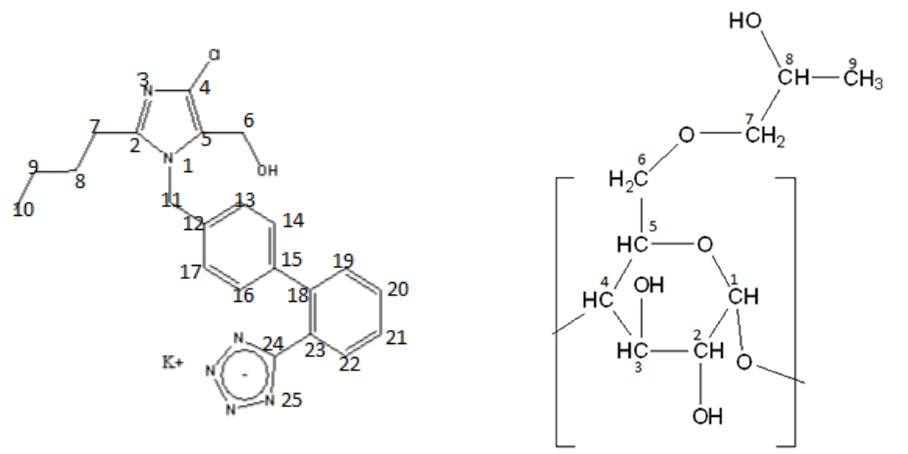
Figure 1. Losartan structure ( left ) and 2-HP- β -CD structure ( right ).